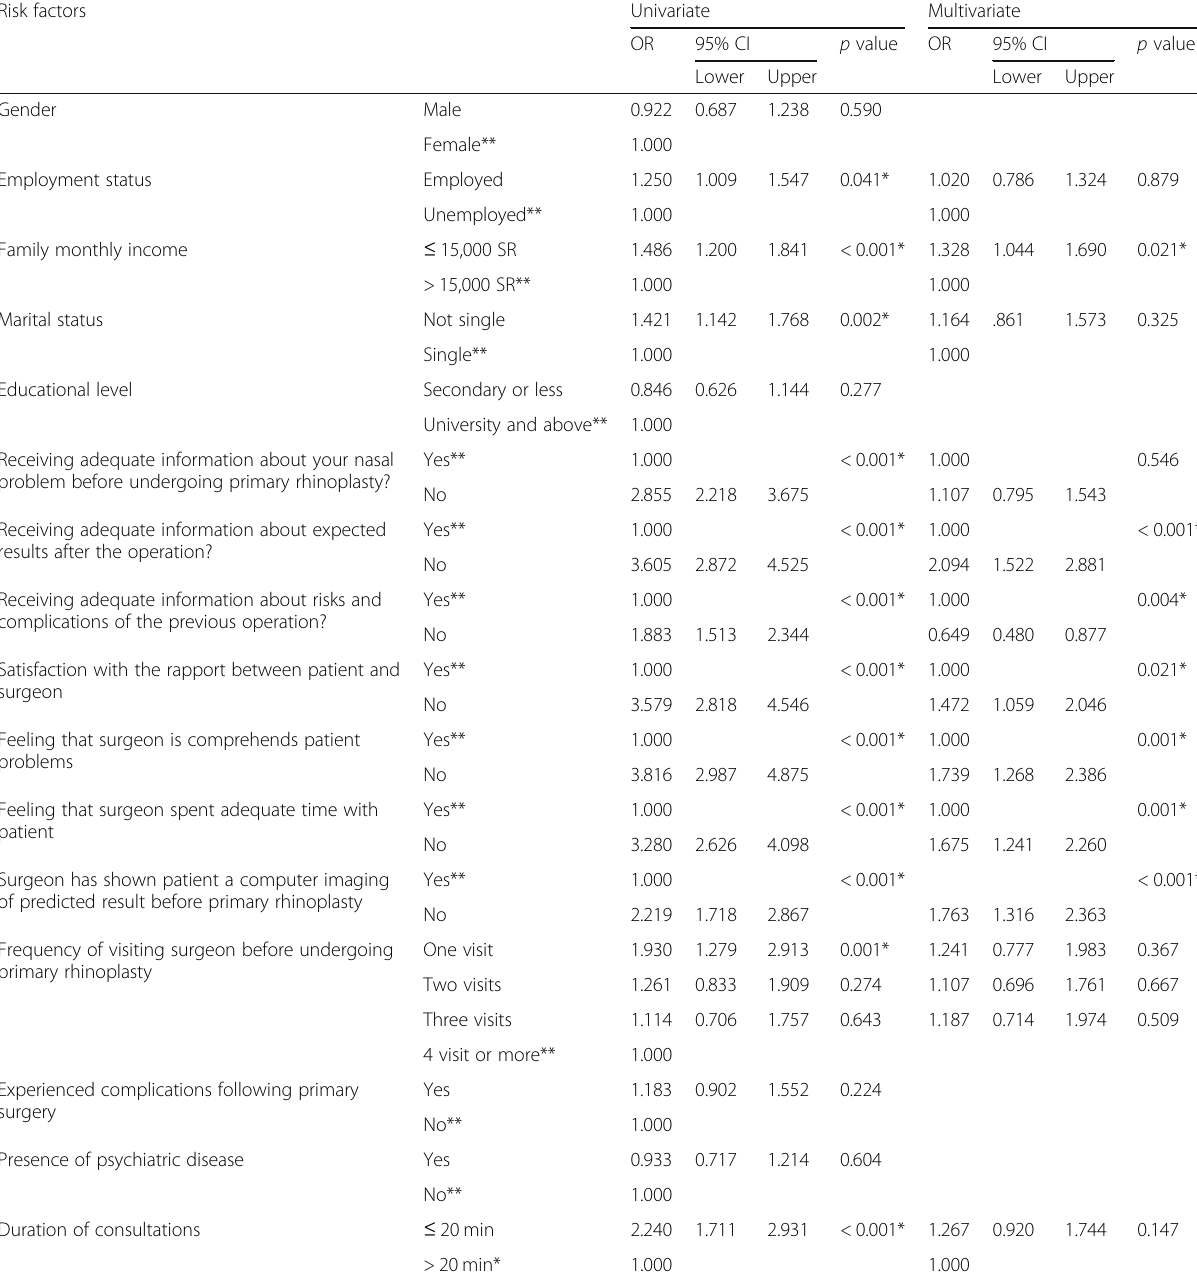
Table 3 Univariate and multivariate logistic regression for risk factors of thinking to seek revision rhinoplasty Risk